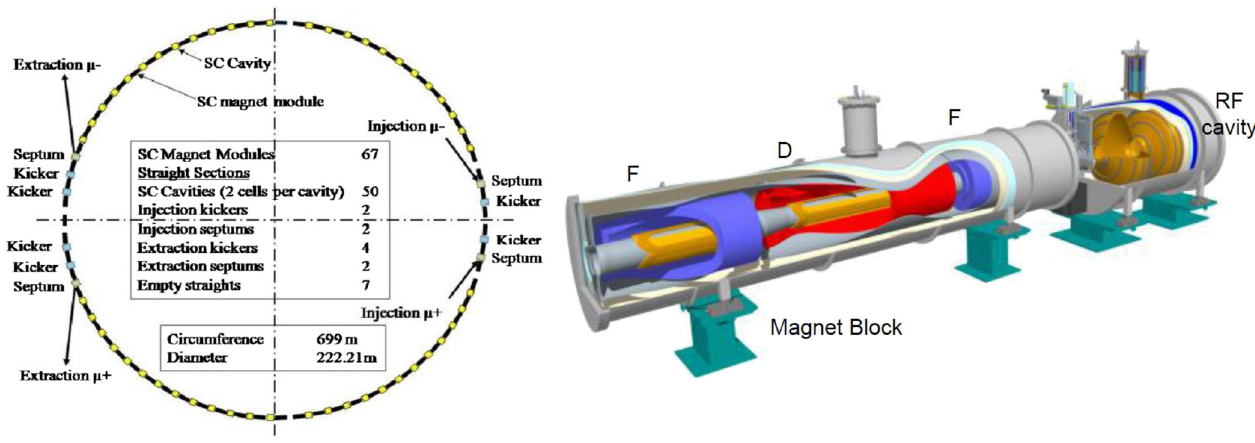
FIG. 12. Left: NS-FFAG layout presented in the IDS-NF IDR [21]. Right: engineering concept for the cryo-modules including three magnets and one cavity.